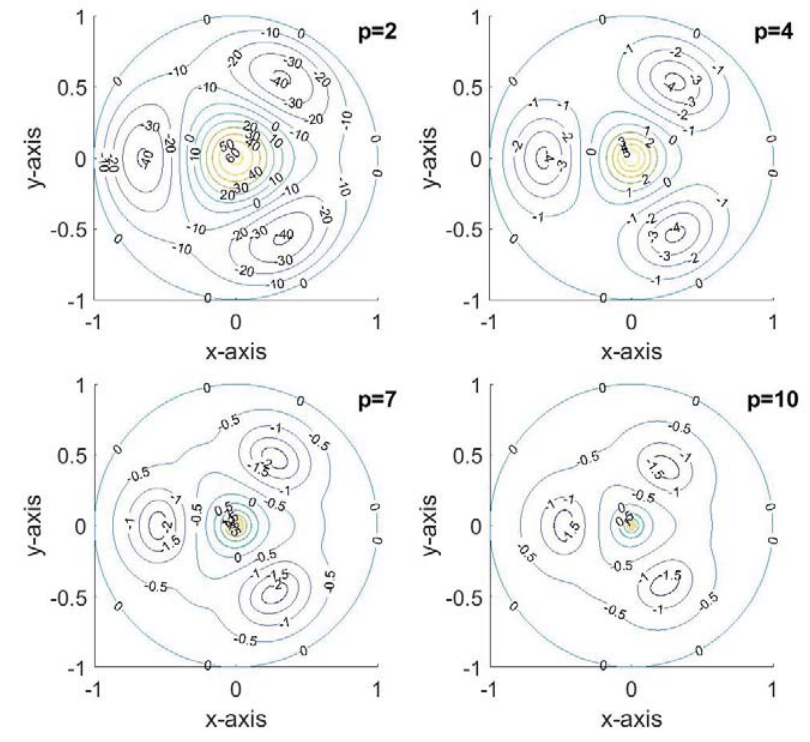
Fig. 14: Level sets of the numerical solutions with two nodal regions and 3-symmetry